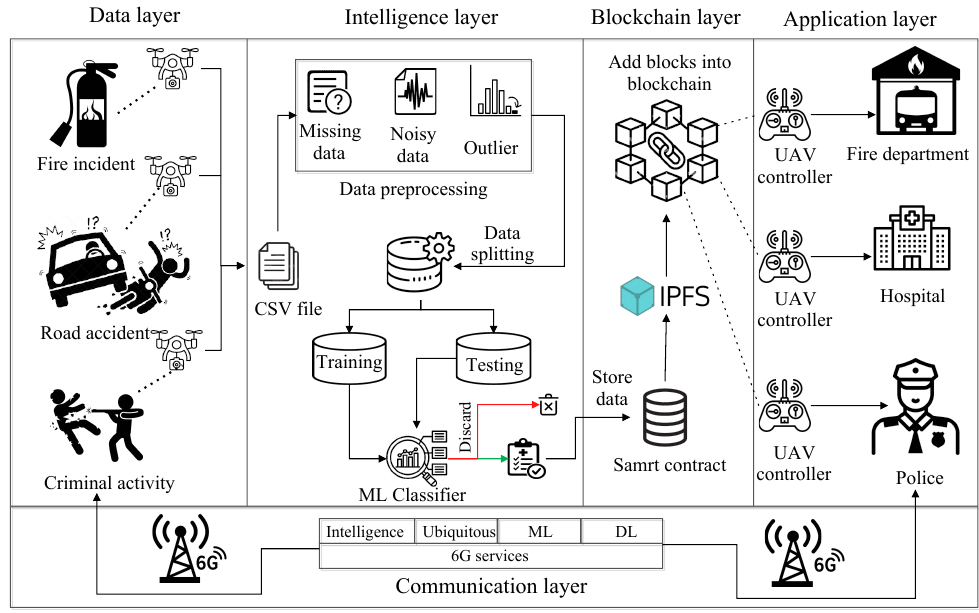
Figure 2. Proposed